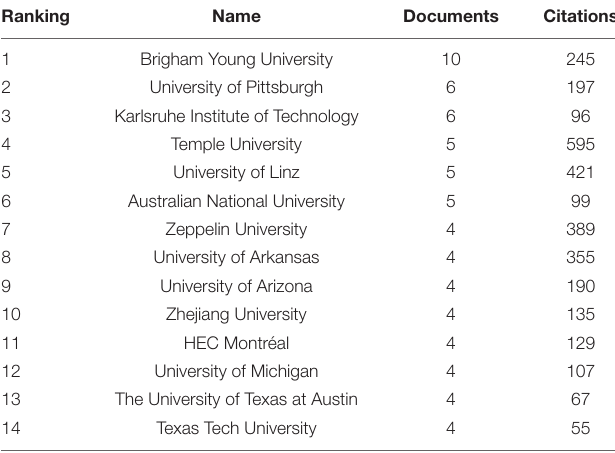
TABLE 5 | Institutions with more than four documents and their